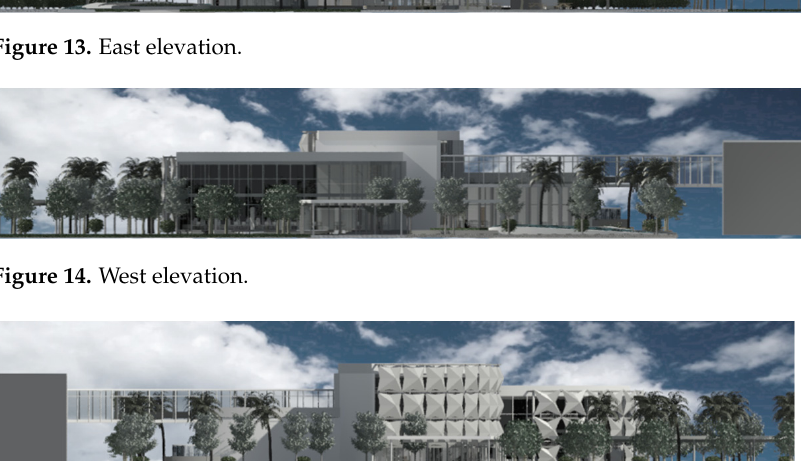
Figure 15. North elevation.